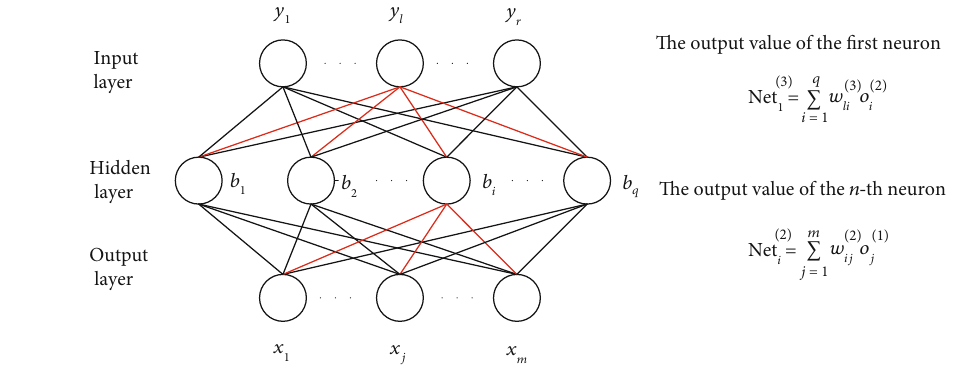
Figure 6: The formation of BP neural network.